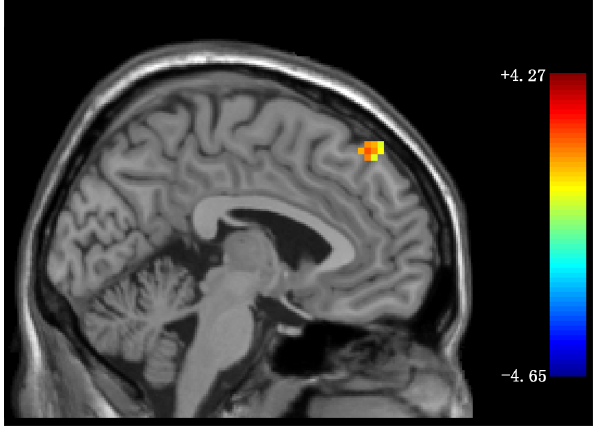
Figure 3. Voxel-wise correlation between the MPFC and the somatization subscale scores of SCL-90 in the patients. Sagittal view of the voxel-wise correlation analysis between z values of the voxels within the the bilateral superior MPFC (Montreal Neurological Institute coordinates: x= 2 4, y=42, z=52) and the somatization subscale scores of SCL-90 in the patient group at 0.05 significance level (combined height threshold p , 0.01 and a minimum cluster size=52). MPFC=medial prefrontal cortex; somatization subscale of SCL-90=somatization subscale of the Symptom Check List. doi:10.1371/journal.pone.0099273.g003 PLOS ONE |